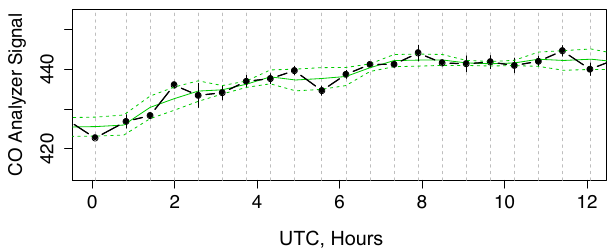
Fig. 6. Measured CO baseline signal s b (black filled circles) linearly interpolated in time (black lines) and smoothed with a running av- erage ( n = 3). The baseline uncertainty u b is the running standard deviation of the residuals (green solid curve, n = 3) represented by the green dashed curves. Note that it is normal for the signal from this type of analyzer to drift upward, which is the reason for the high values seen